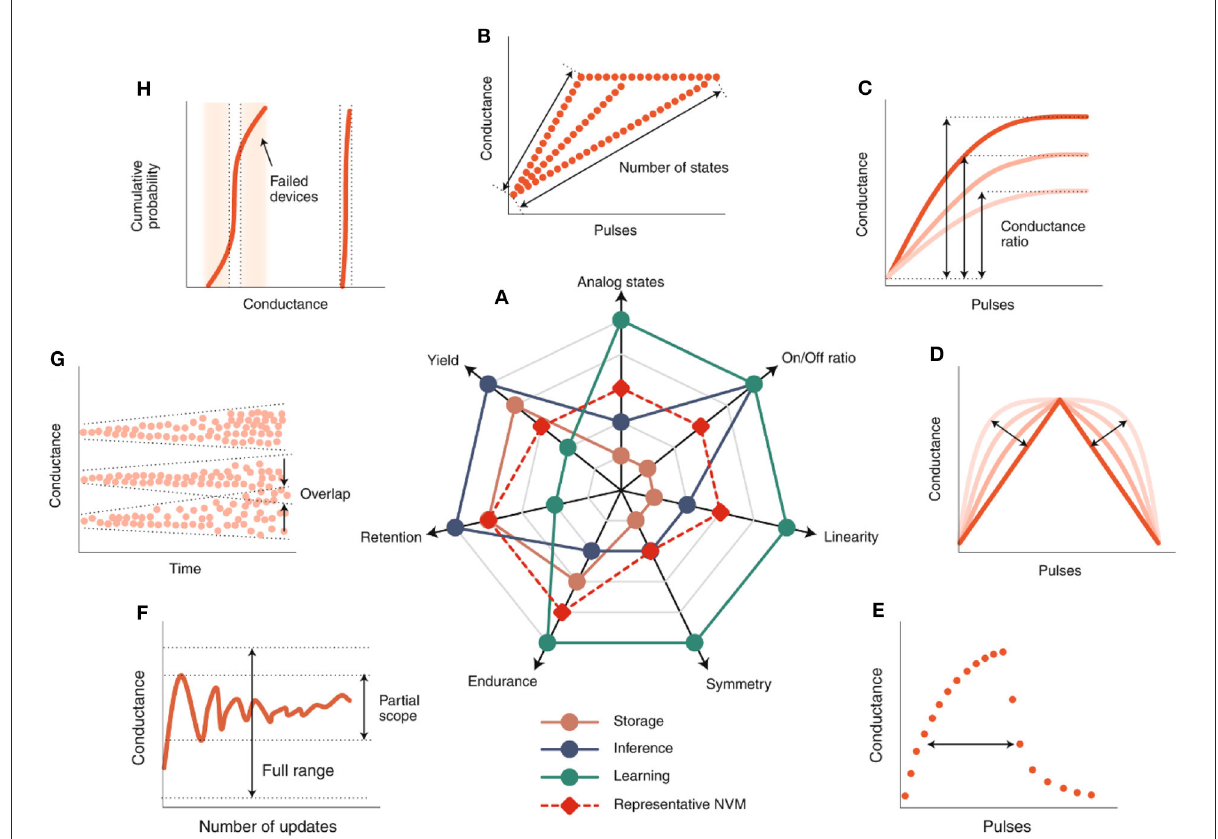
FIGURE6 Application-dependent device metric requirements (Zhang W. Q. et al., 2020). (A) Ranking of qualitative device requirements for three potential applications and NVM. (B96-H) , schematic diagram of computing device requirements: (B) simulation state, (C) on/off ratio, (D) linearity, (E) symmetry, (F) durability, (G) retention rate and (H) yield.